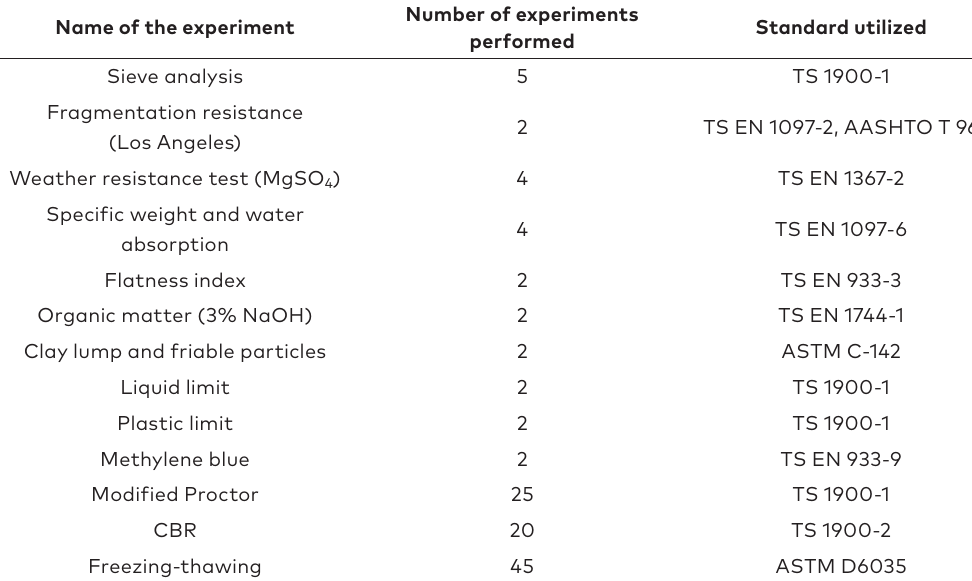
Table 4. Number of experiments and standards